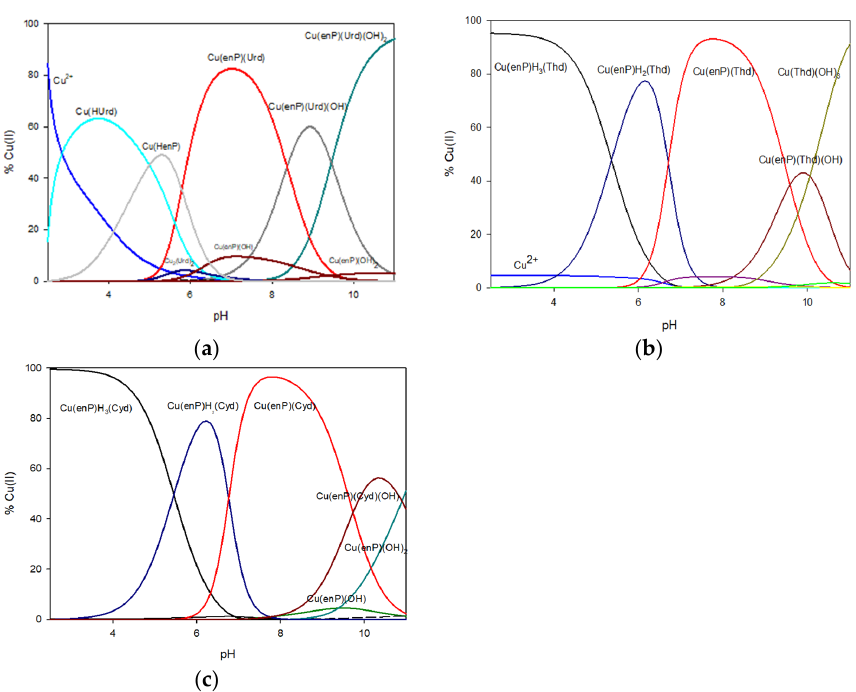
Figure 2. Distribution diagrams of the species formed in the systems: ( a ) Cu(II)/enP/Urd, ( b ) Cu(II)/enP/Thd and ( c ) Cu(II)/enP/Cyd. (For the sake of simplicity, ion charges in potentiometric description of the complexes were omitted.).